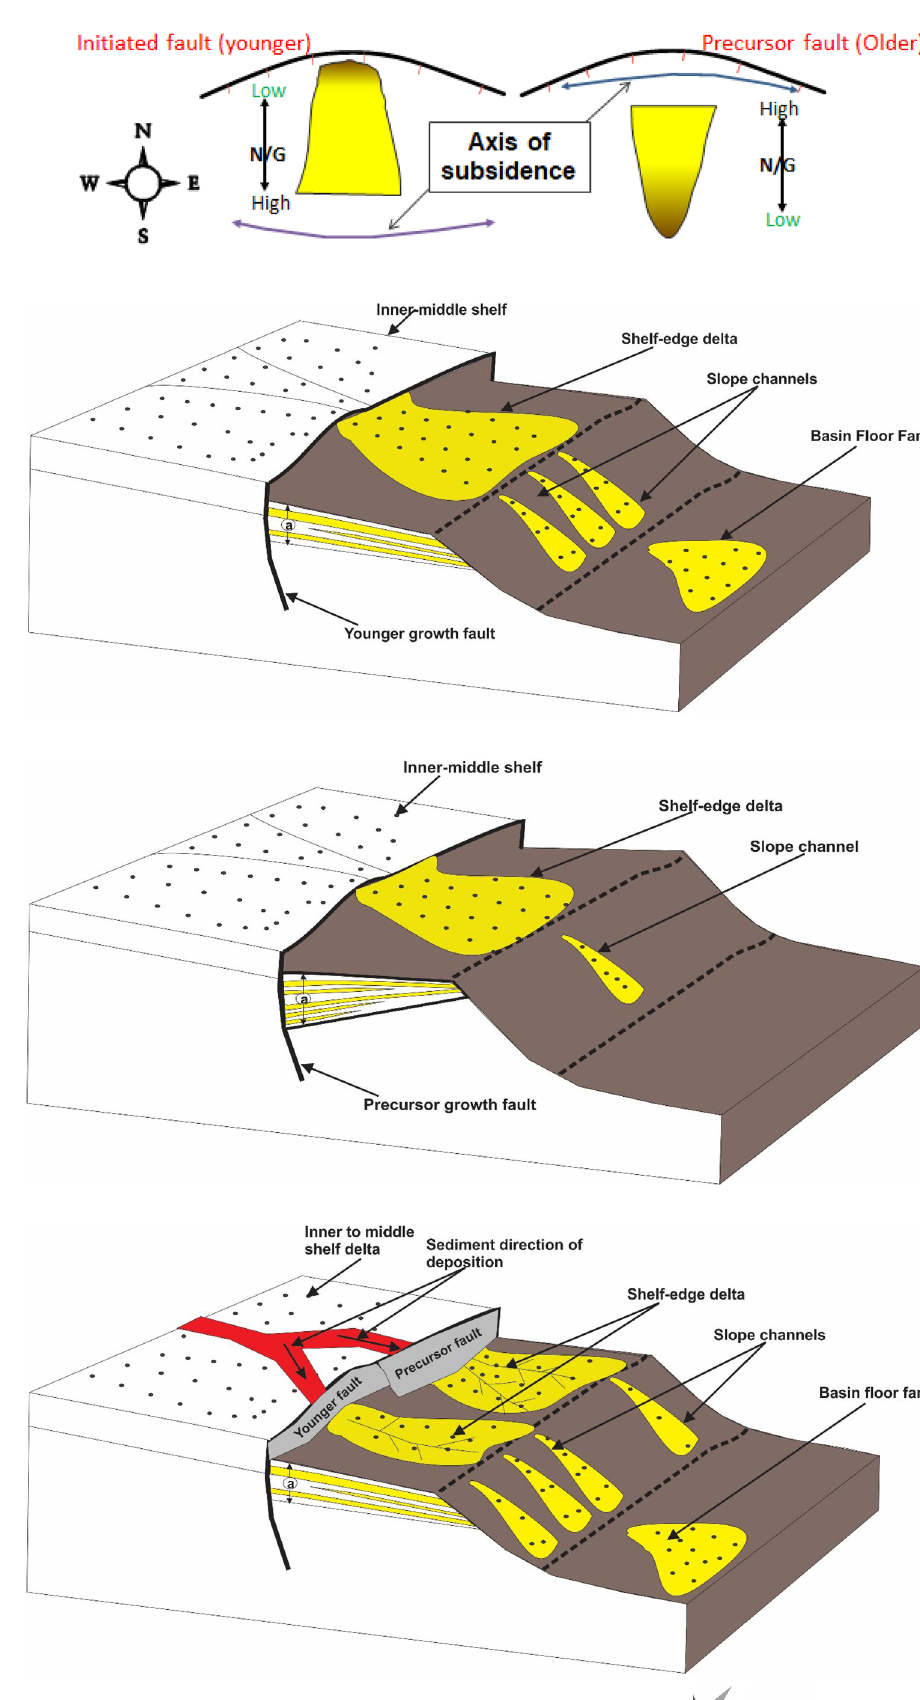
Fig. 22 Changes in net to gross and axis of subsidence arising from same sequence associated with precursor and younger co- planar faults